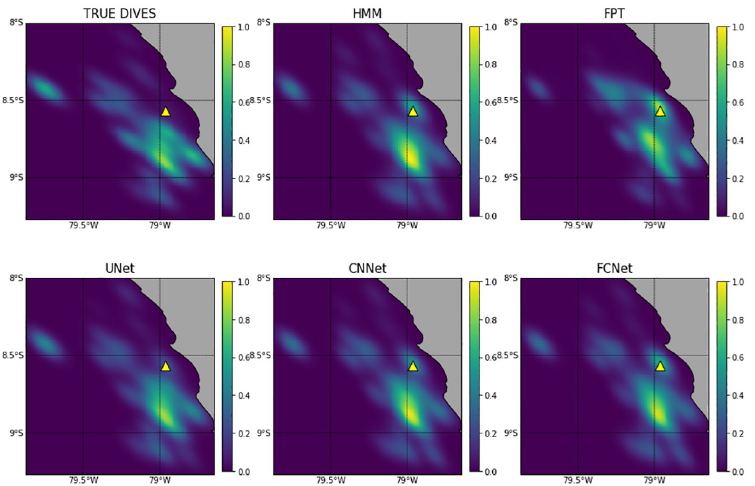
Fig 6. Maps of dive distributions of Peruvian boobies from Gua ñ ape Island. —These density maps were obtained through Kernel Density Estimation. The top left map has been computed from true dives derived from TDR data. The five other maps are estimations of this map, using all points of the trajectories with weights associated to diving probabilities estimated by the studied approaches: First-Passage Time (FPT), Hidden Markov Model (HMM), Fully Connected Network used by [17] FCNet (top right), fully-Convolutional Network (CNNet), and the U-Network (UNet). Dive map mean square error (MSE) between estimated and reference distribution are in Table 3. Land-sea mask is extracted from GSHHG data (https://www.soest.hawaii.edu/pwessel/gshhg/).